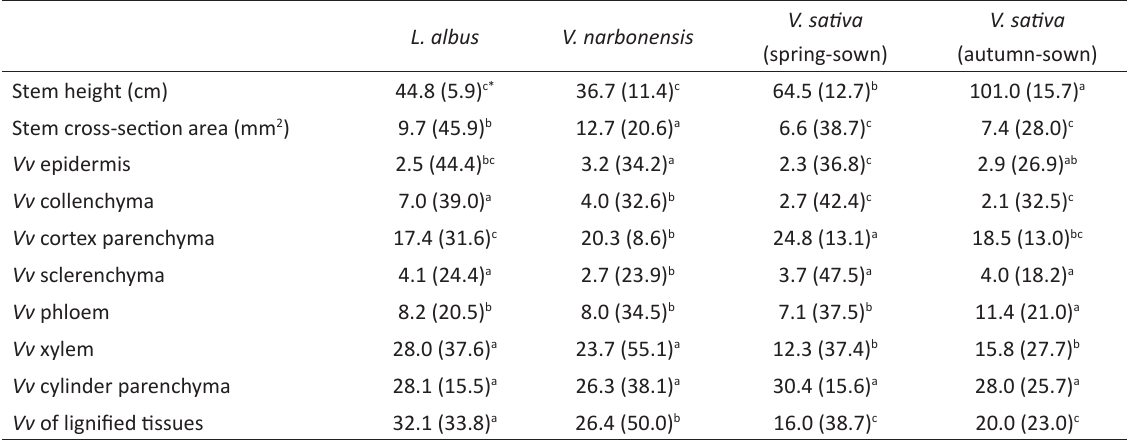
Table 3. Means and comparisons of stem morphological parameters and volume densities ( Vv ) of stem tissues of legume forage species grown as sole crops. CVs values (%) are given in parenthesis. L. albus V.